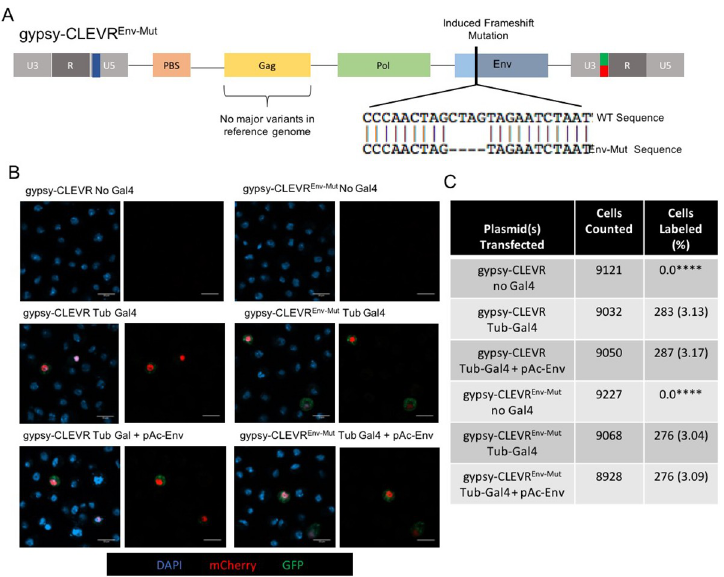
Fig 5. Functional env is not required for the intracellular retrotransposition of gypsy. Cartoon schematic showing the overall structure of the gypsy-CLEVR Env_mut construct, which is identical to gypsy-CLEVR but has a frameshift mutation within the env ORF, seen in detail in the sequence comparison directly below. B) Fluorescent images showing the absence of WM signal in gypsy-CLEVR and gypsy-CLEVR Env_mut populations lacking Gal4, and positive WM signal in gypsy-CLEVR and gypsy-CLEVR Δ Env when co-transfected with tubulin Gal4 as well as with pAc-Env. C) Quantification of the percentage of cells that showed positive WM signal for gypsy-CLEVR and gypsy-CLEVR Δ Env with and without Gal4, as well as with pAc-Env. No statistically significant differences were found absent gypsy- CLEVR and gypsy-CLEVR Env_mut lacking the presence of Gal4. Quantification is presented as totals cells counted from 3 near equivalent sets of biological replicates. Significance was determined using the Fisher’s Exact test variant of the Chi 2 test. Significance values are denoted as: p = < 0.05 � , p = < 0.001 ��� , p = < 0.0001 ���� Raw data for cell counts shown in S1